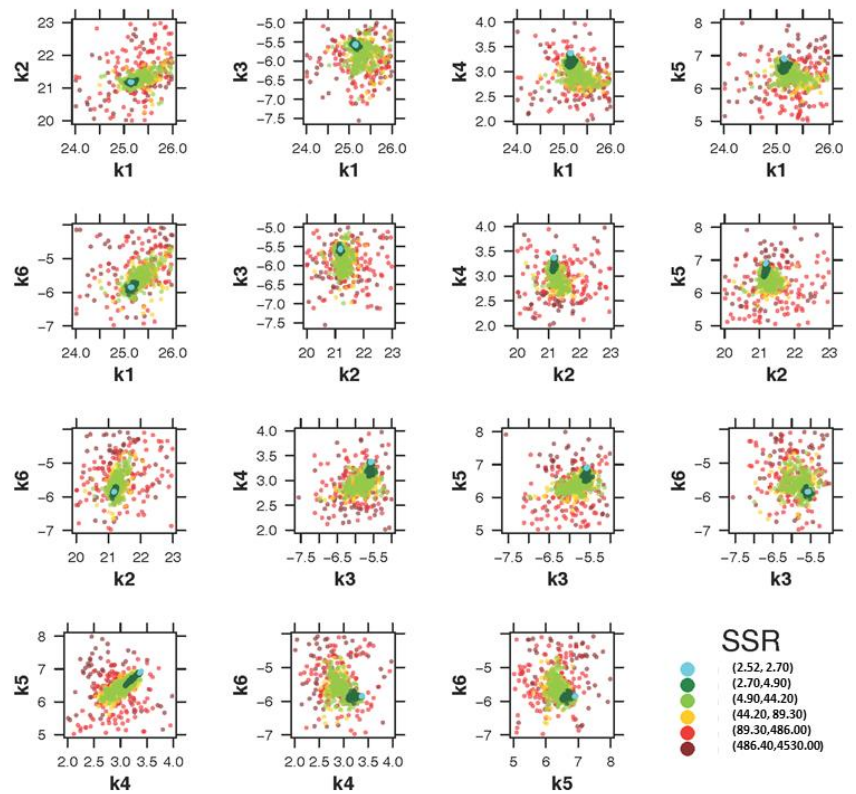
Figure 5. Quasi-three-dimensional dotty